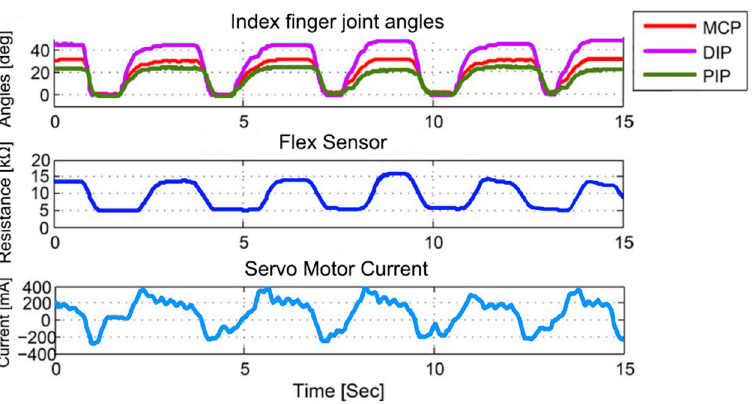
Figure 21. Index finger motion, filtered flex sensor output, and current drawn by servo motor during the pick-and-place task.